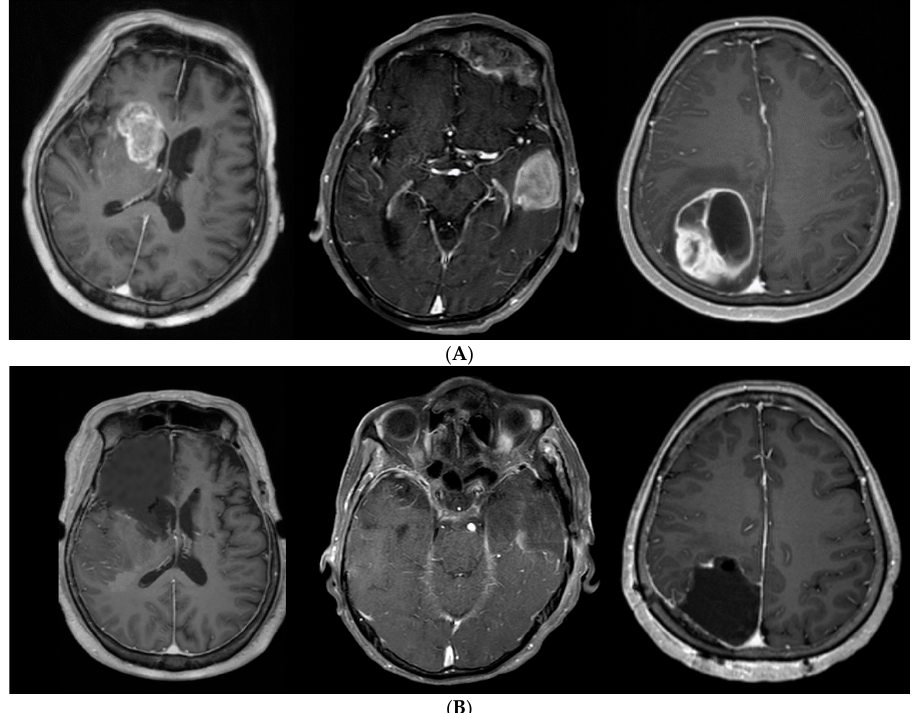
Figure 2. (A ). Preoperative axial T1-weighted gadolinium-enhanced MRI showing a GBM involving the frontal, temporal and occipital lobes. ( B ). An example of a patient in whom SupTR was achieved. After complete resection of the tumor, a frontal, temporal and occipital lobectomy was performed.